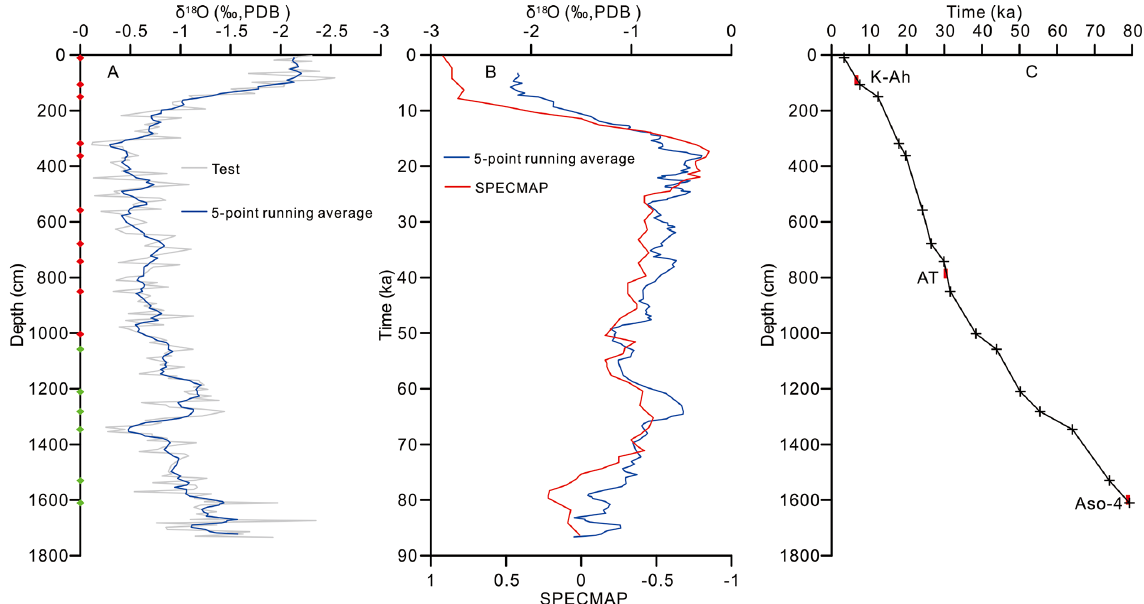
Figure 3. (a) δ 18 O of planktonic foraminifera G.ruber plotted against depth (cm) for core CSH1. The age control point for AMS 14 C and δ 18 O are indicated by the red and green diamonds, respectively. (b) Five-point running average δ 18 O of planktonic foraminifera G. ruber for core CSH1 and the SPECMAP (Spectral Maping Project) curve (Martinson et al., 1987) plotted against age over the last 88ka. (c) Plot of measured ages vs. depth for core CSH1. The three known ash layers are indicated by solid red rectangles.